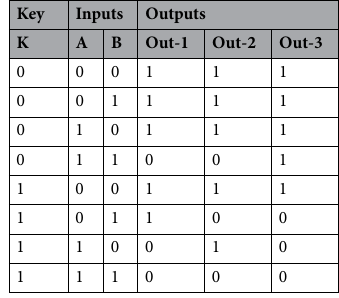
Table 7. Truth table for analysis of proposed NAND gate.